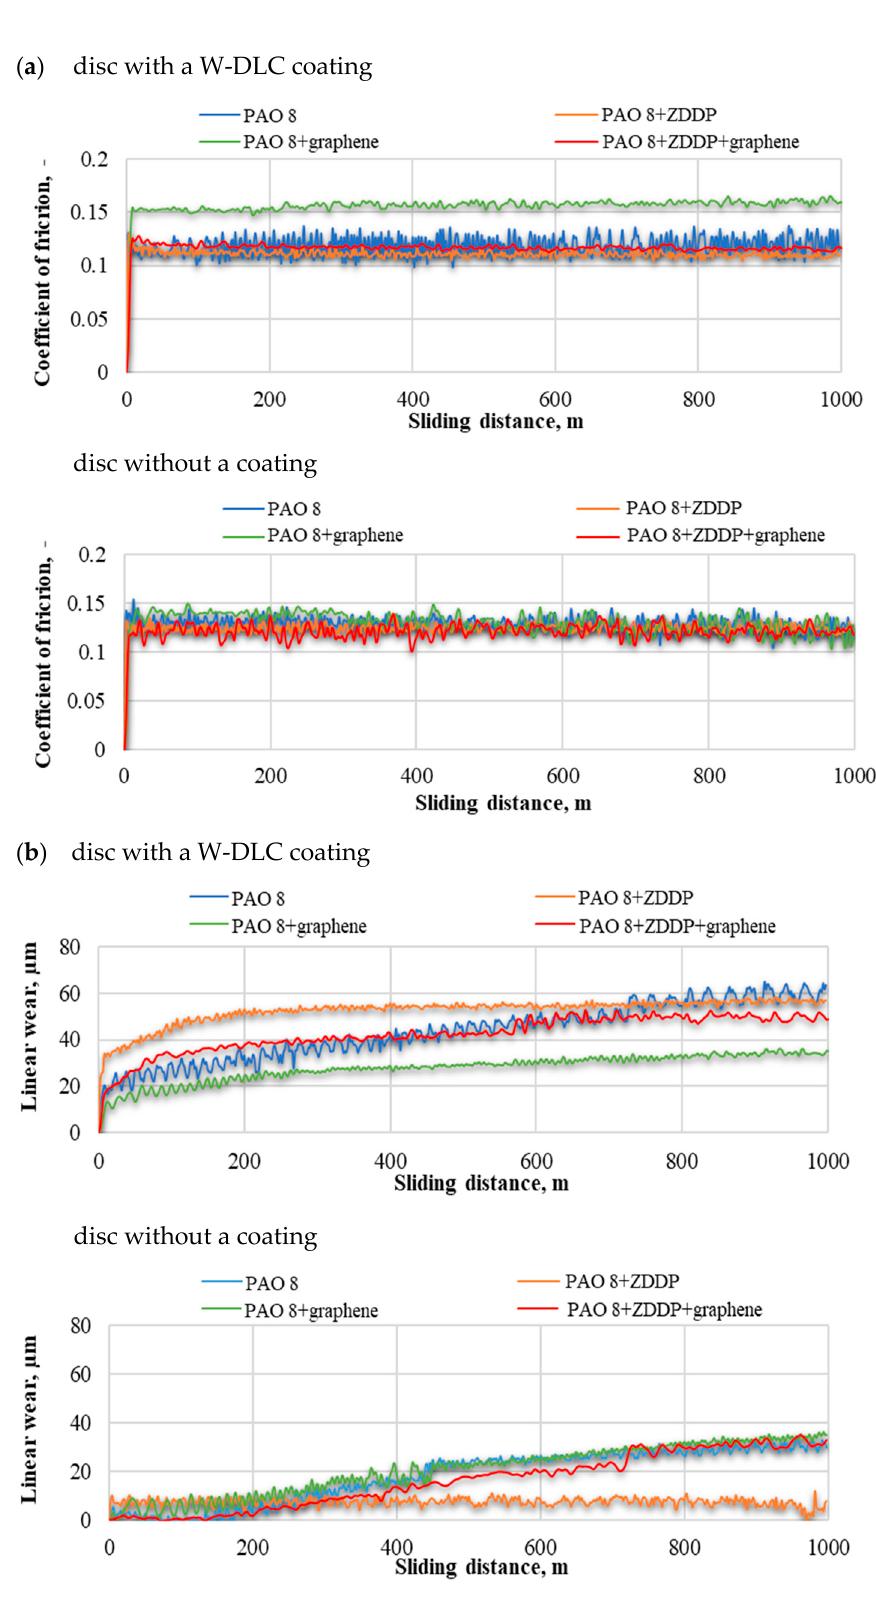
Figure 3. The tribological parameters: ( a ) coefficient of friction and ( b ) linear wear. From the test results, it is clear that the lowest coefficient of friction was reported for the coated discs lubricated with PAO 8 + ZDDP. The results concerning the uncoated discs indicate that the coefficient of friction was lower when lubrication was provided